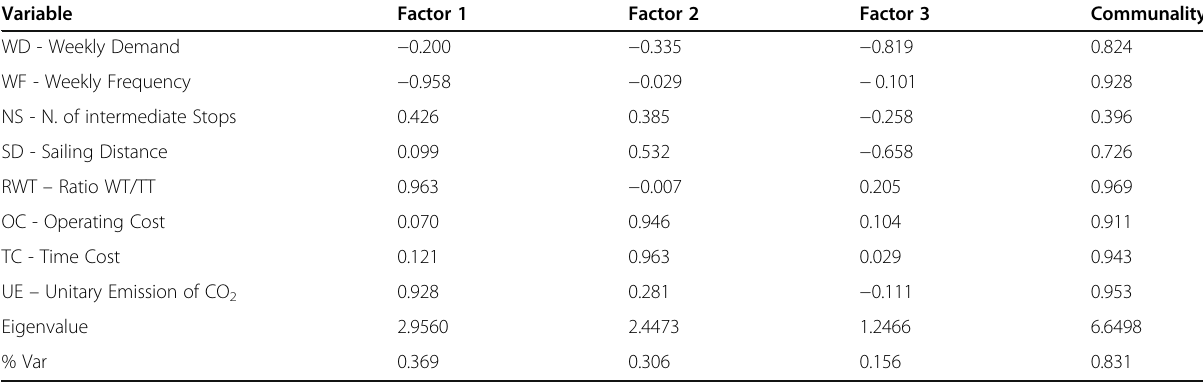
Table 6 Rotated factor loadings and communalities using Varimax rotation – Existing network Variable Factor 1 Factor 2 Factor 3